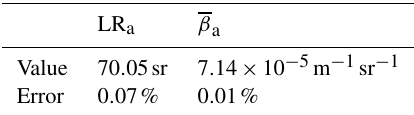
Table 3. Plume optical property retrieved and associated